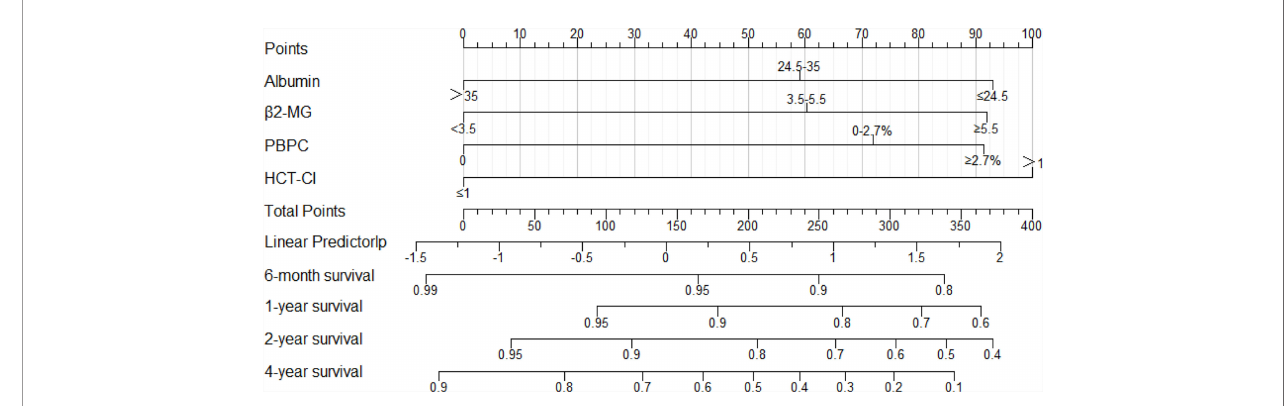
FIGURE 1 | The nomogram derived from the development cohort to predict OS of NDMM patients. The precise values of each variable are showed in Supplemental Table S2 . Also, the likelihood of 6-month, 1-year, 2-year, or 4-year survival was predicted according to the total points which are located on the corresponding axes.